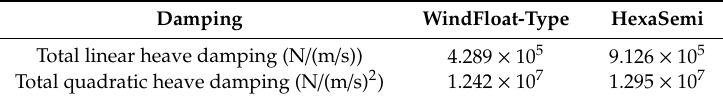
Figure 7. Free decay curves of heaving (WindFloat-type platform and HexaSemi). Table 3. Total linear and quadratic heave damping of the two platforms.